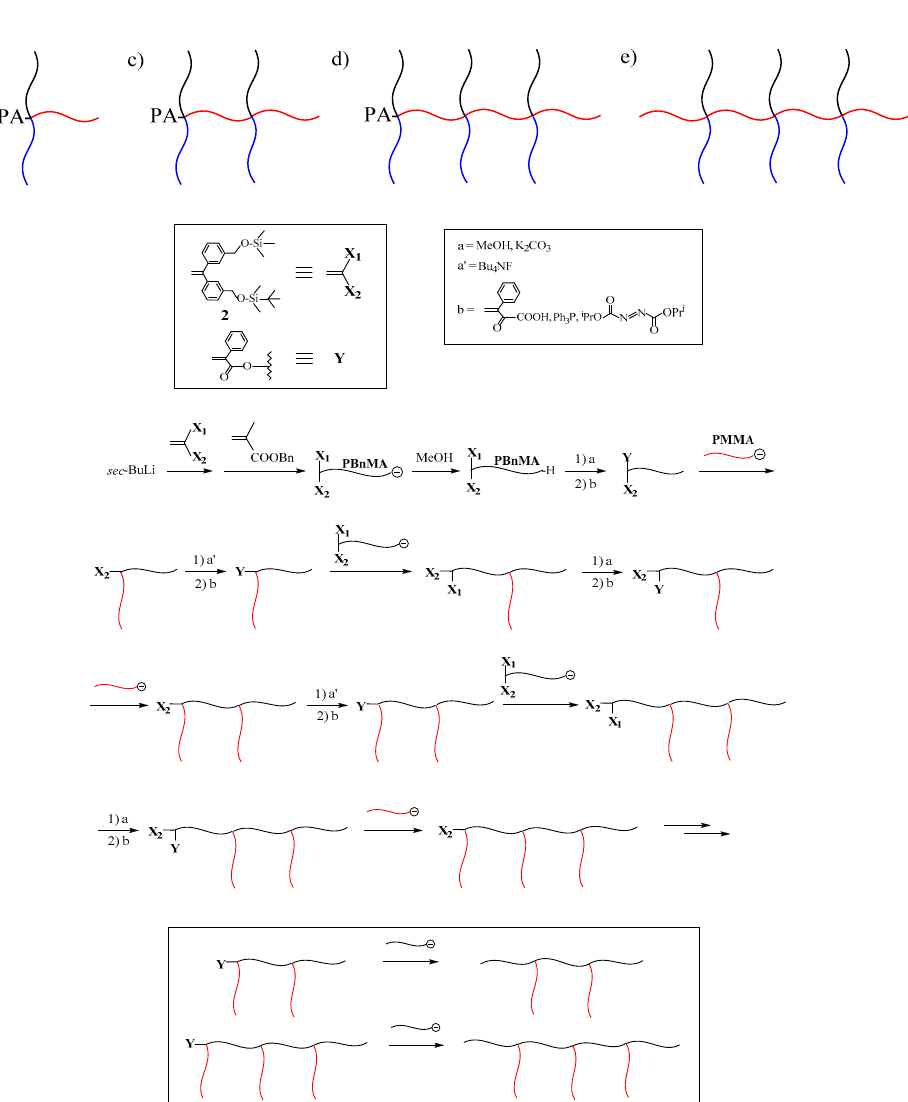
Table 8. Characterization results of (EDGP)s by the iterative